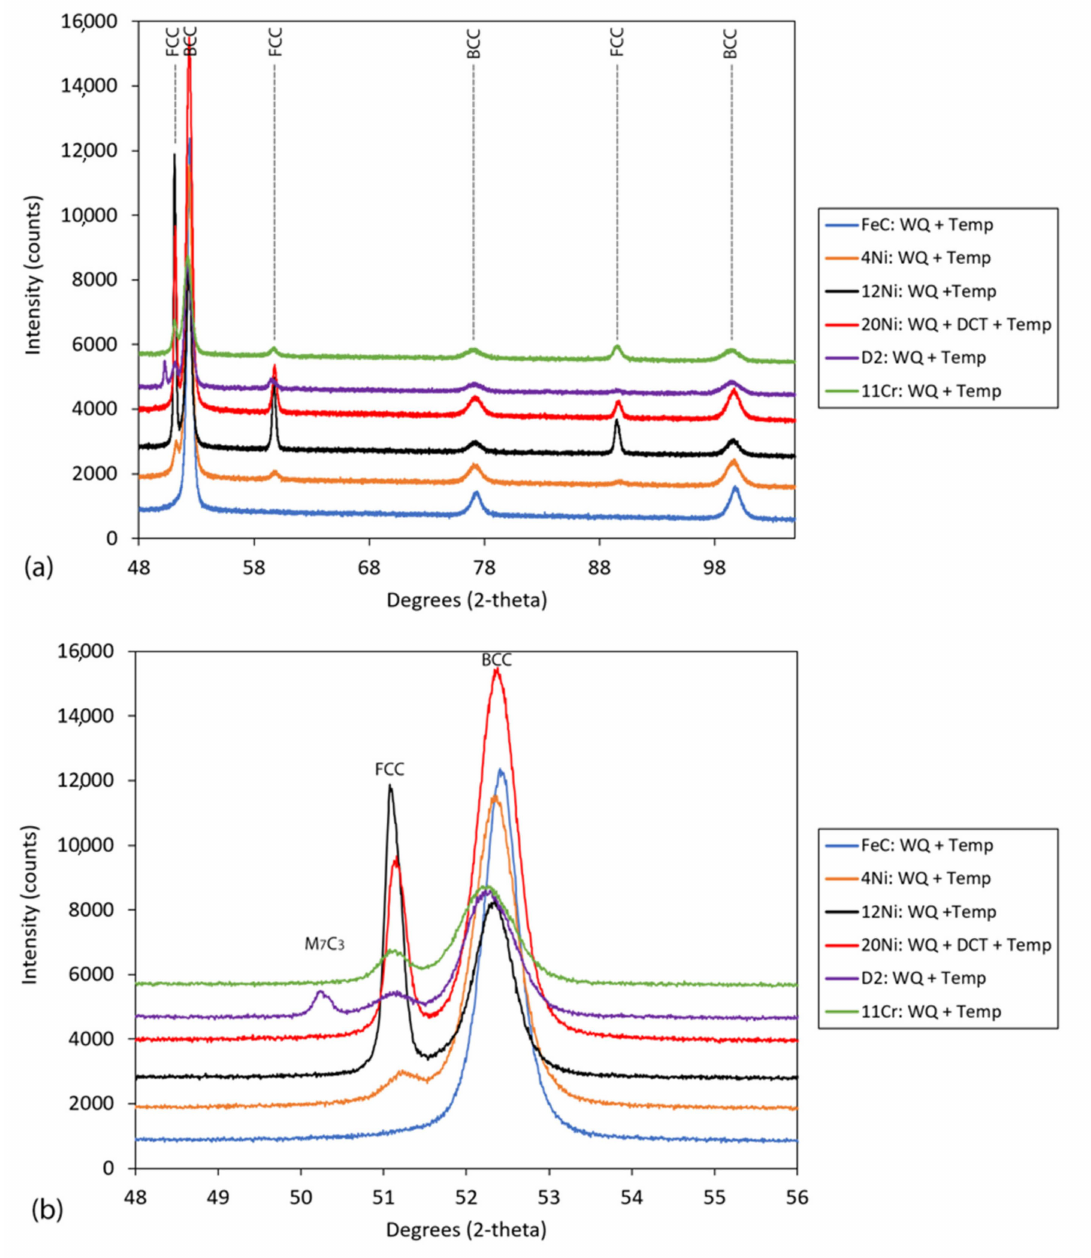
Figure A3. X-ray di ff ractograms of selected specimens as indicated in the figure legend. Note the lack of austenite in the binary Fe-0.6C alloy. Data from ( a ) are re-plotted in ( b ) showing the peaks of highest intensity in more detail. Note that these di ff ractograms were measured using Cobalt K α